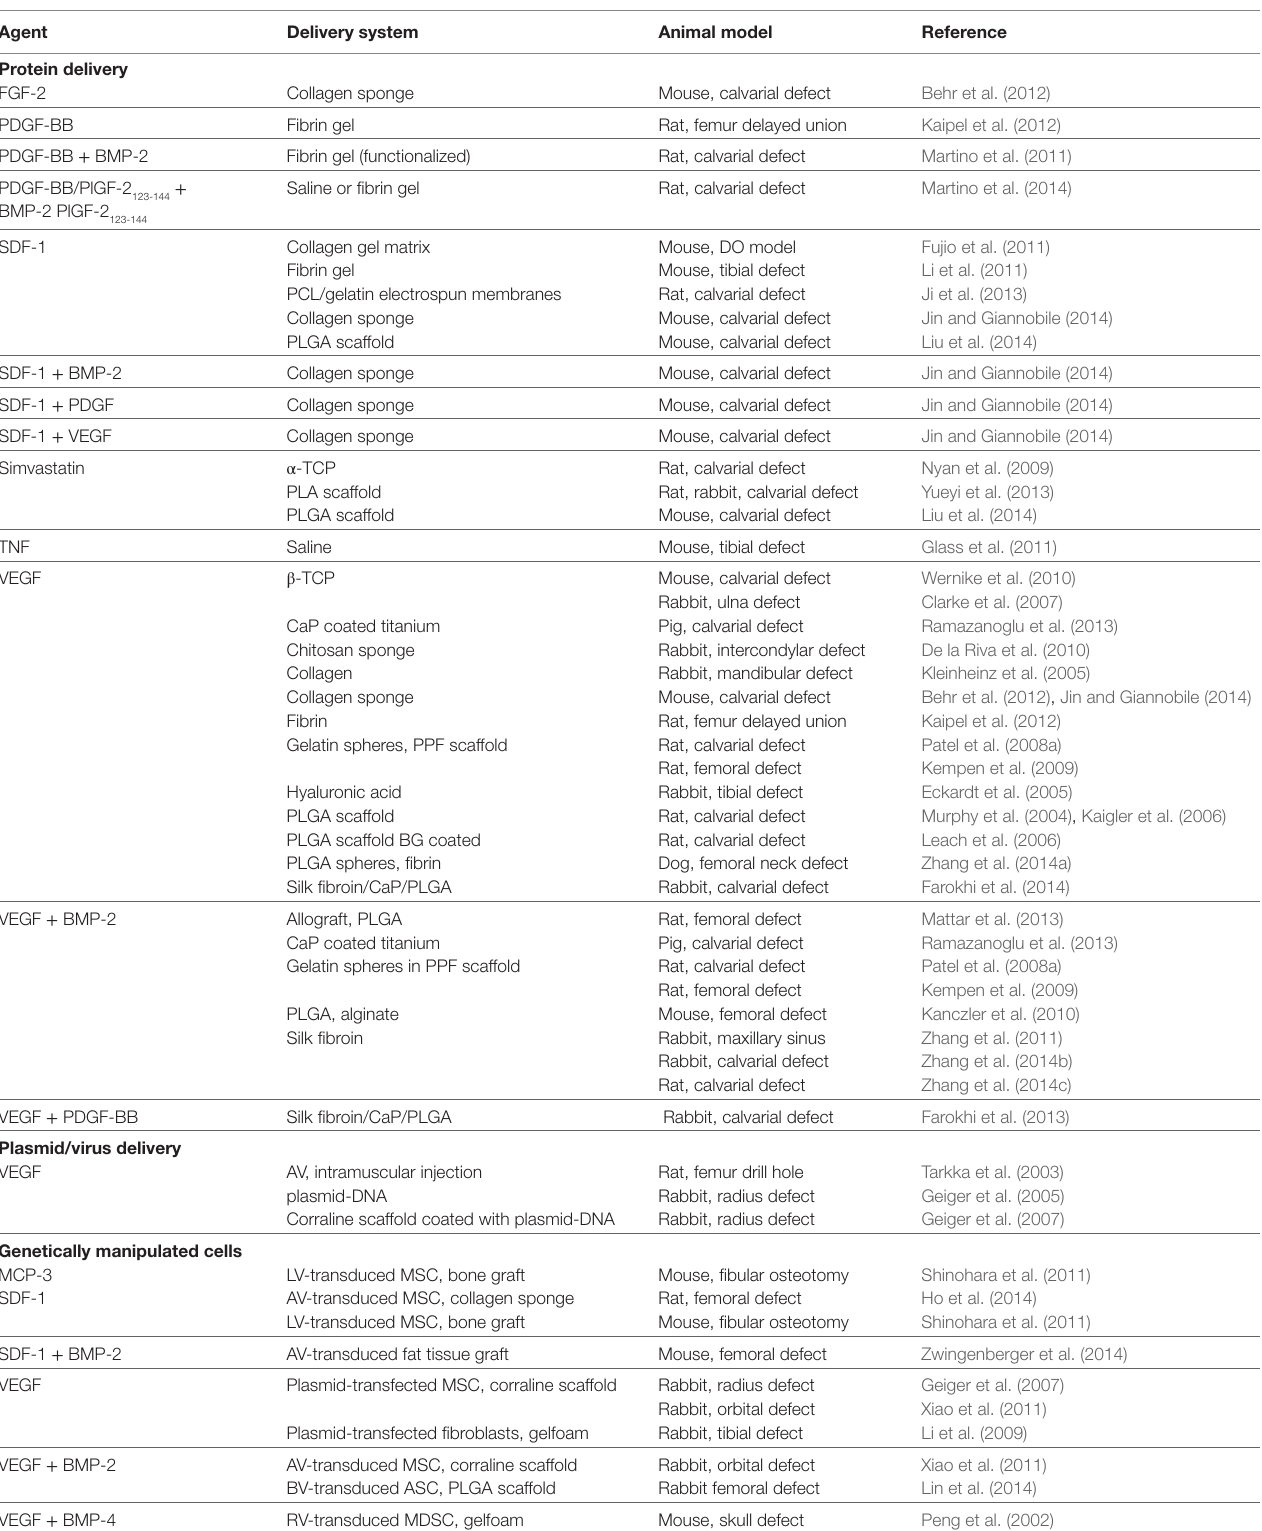
TabLe 1 | Homing factors for bone